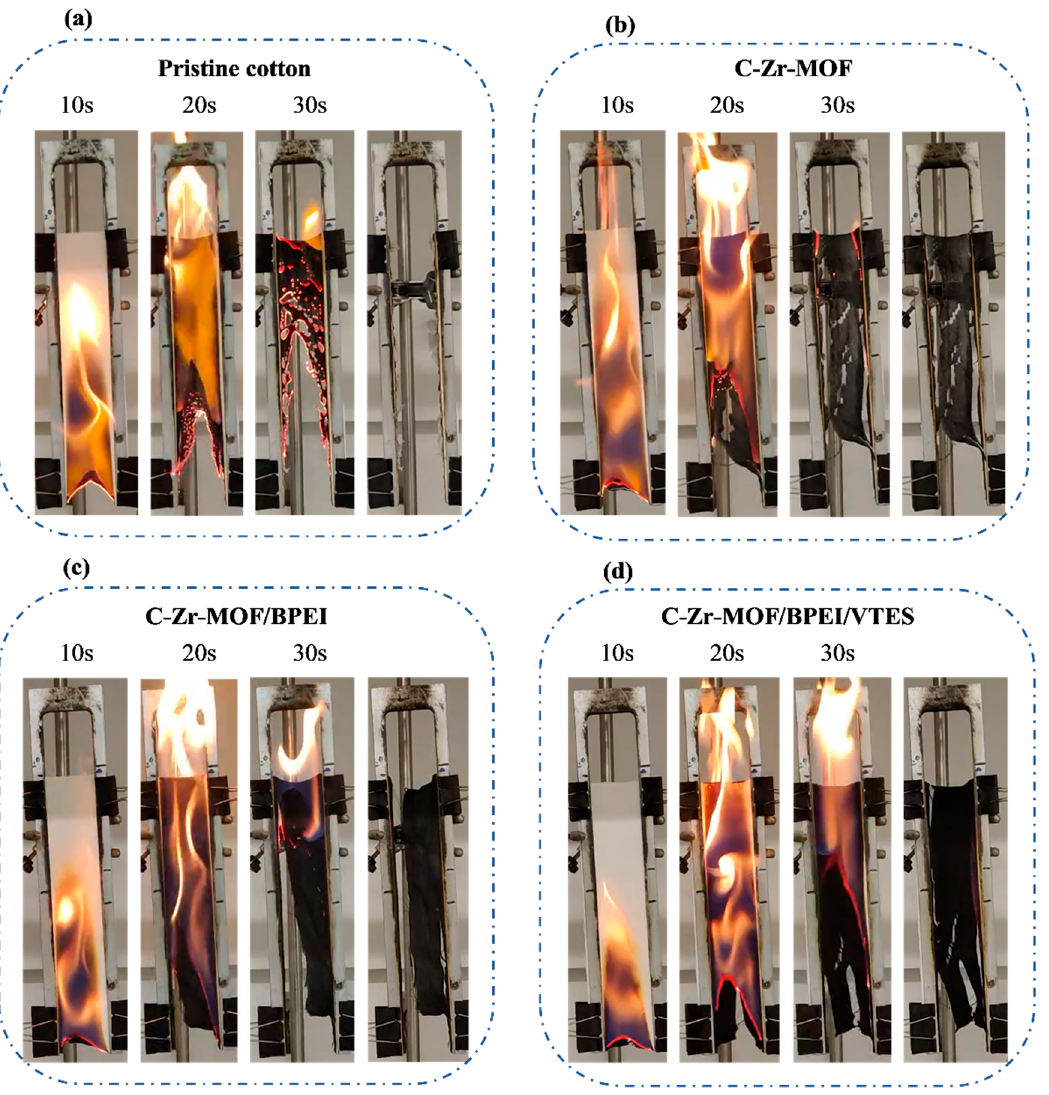
Figure 3. Digital photos of ( a ) pristine cotton; ( b ) C-Zr-MOF; ( c ) C-Zr-MOF/BPEI; and ( d ) C-Zr- MOF/BPEI/VTES in the vertical burning test after ignition.